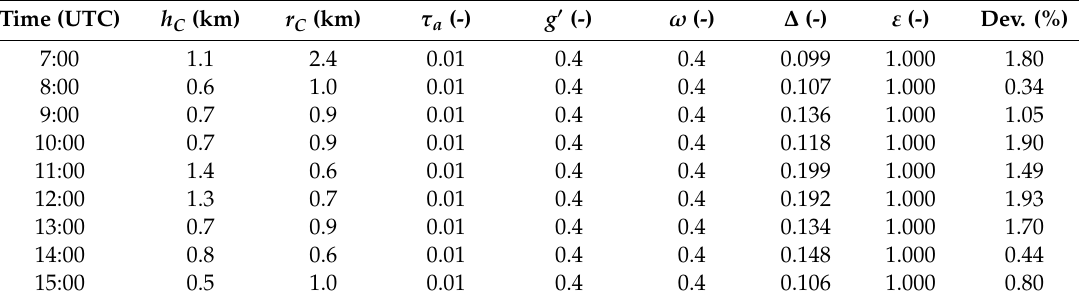
Table 4. The same as in Table 3, but for 24 February 2015 (overcast